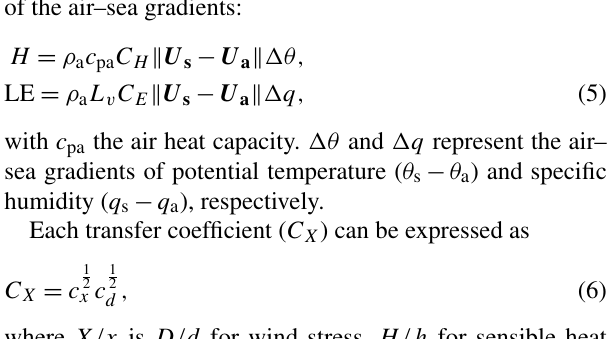
Table 1. List of the exchanged